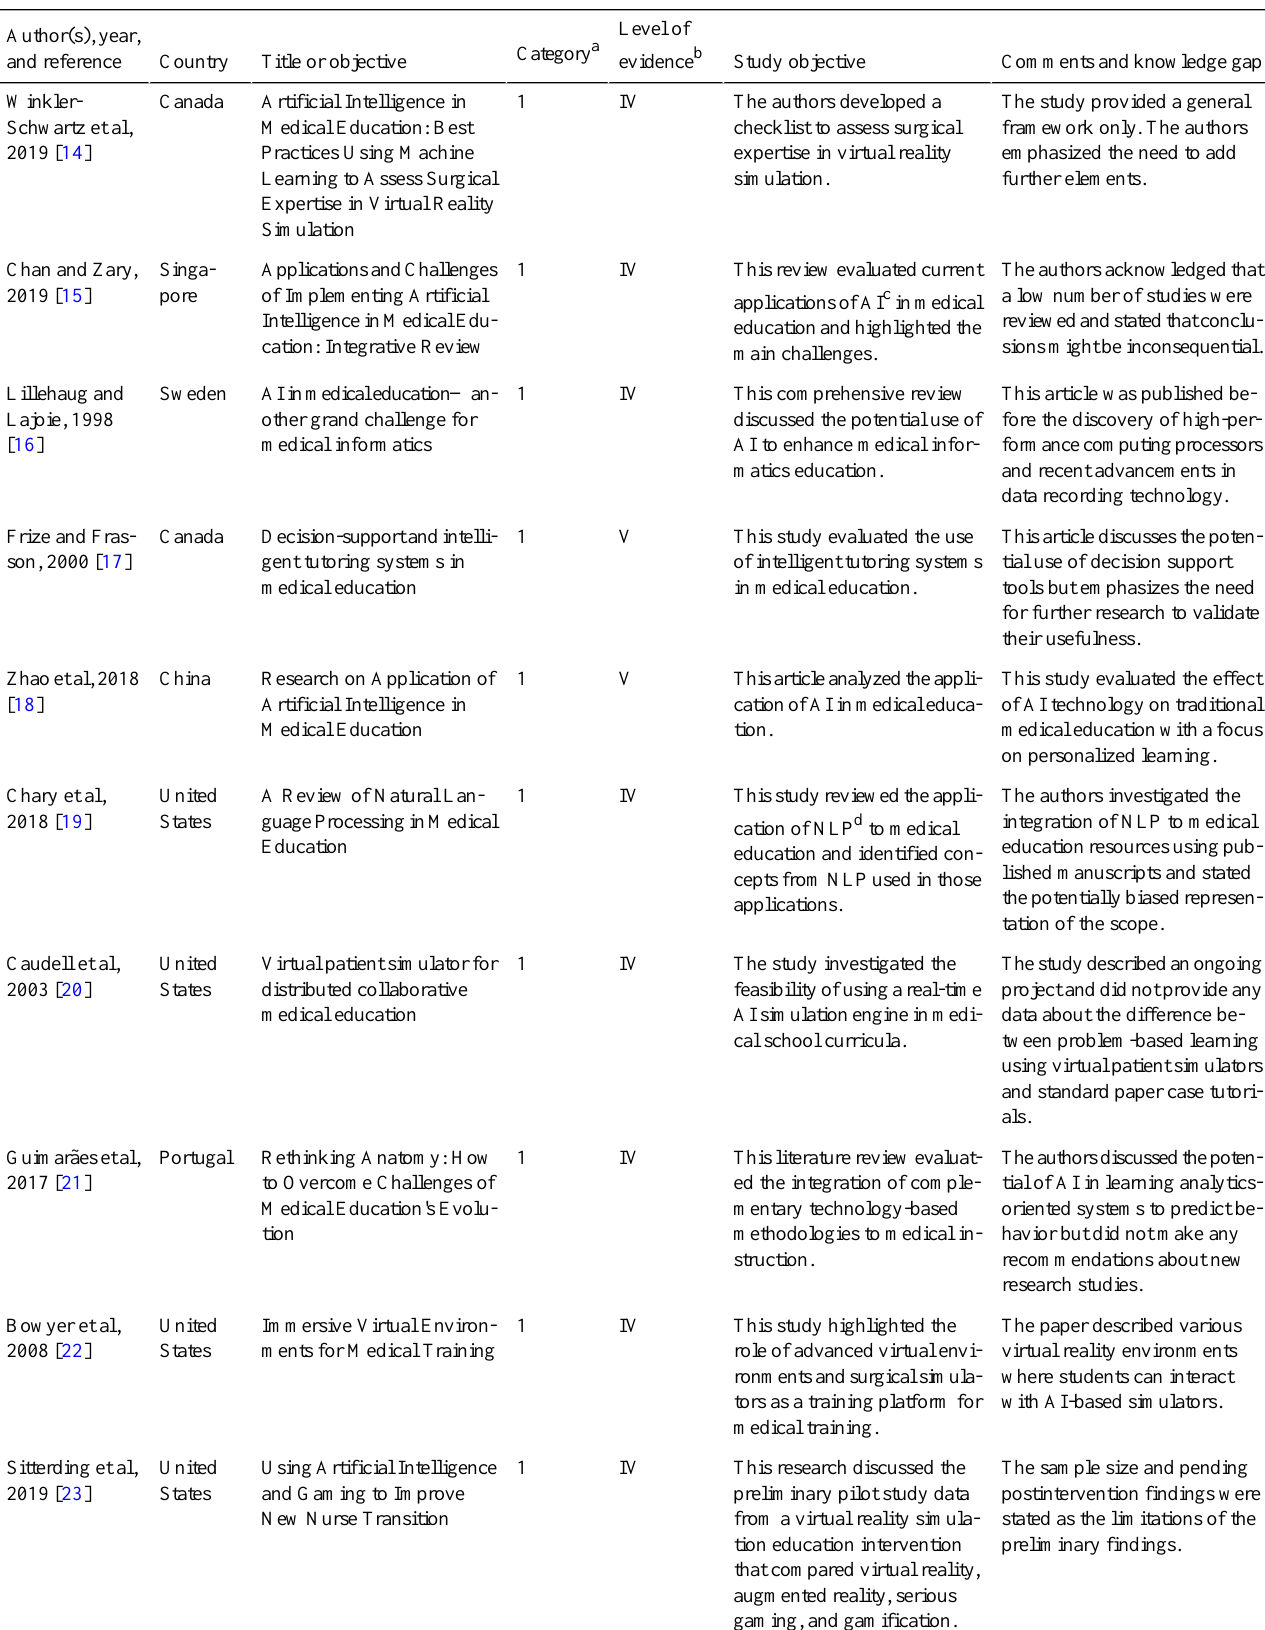
Table 2. Characteristics of included